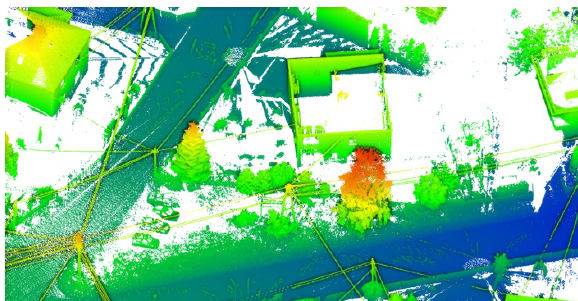
Figure 6 . Part of TLS point cloud collected in 2018. Point colours according to heights.